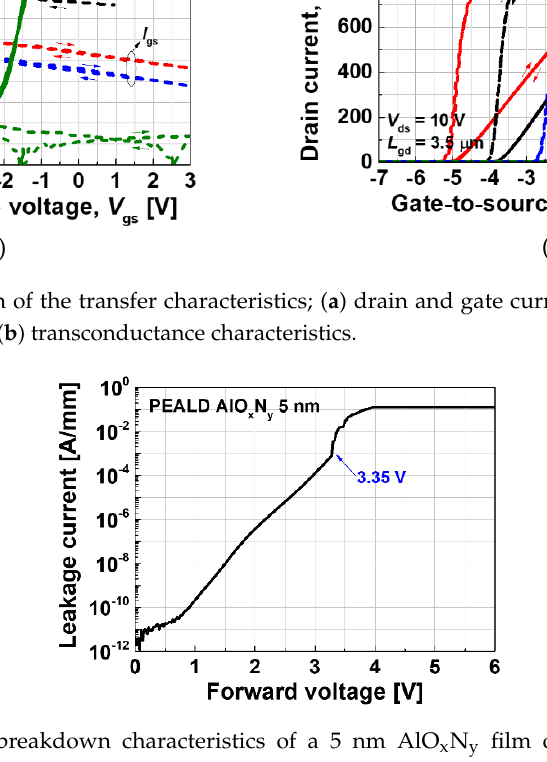
Figure 3. Forward breakdown characteristics of a 5 nm AlO x N y film on an 11 nm recessed AlGaN/GaN surface.